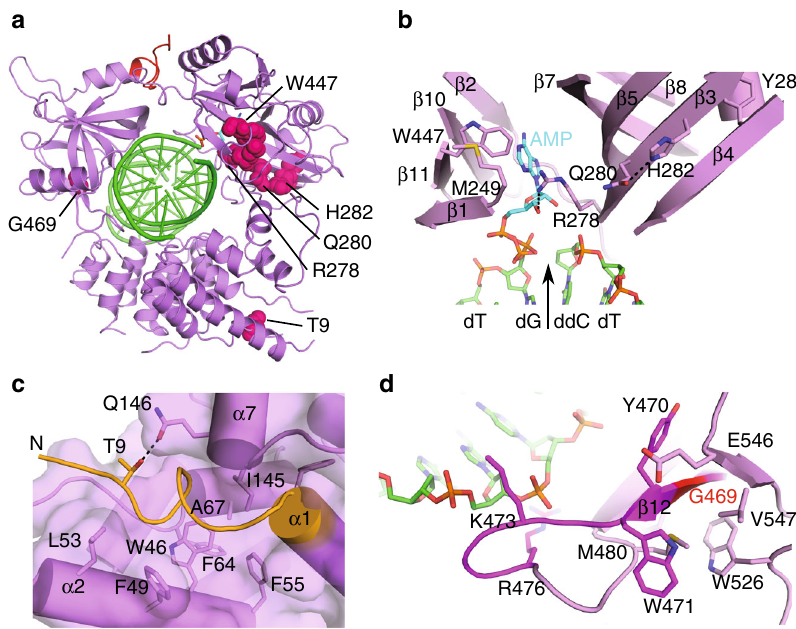
Fig. 8 Structural insights into LIG4 syndrome mutations and polymorphisms. a Known LIG4 syndrome mutations (residues in space- fi lling representation, hot pink) mapped onto the LigIV closed DNA – adenylate structure (protein in purple, DNA in green). b Relative positions of mutations near the AMP (cyan) binding site of human LigIV that have been associated with LigIV de fi ciency. c Conformation of the LigIV N-terminus (orange), and its putative role in protein folding and stability. Thr9 makes a putative hydrogen bond with Gln146, which could be disrupted when mutated to isoleucine. d Disposition of residues in Motif Va (magenta, with Gly469 in red), in relation to the bound DNA substrate